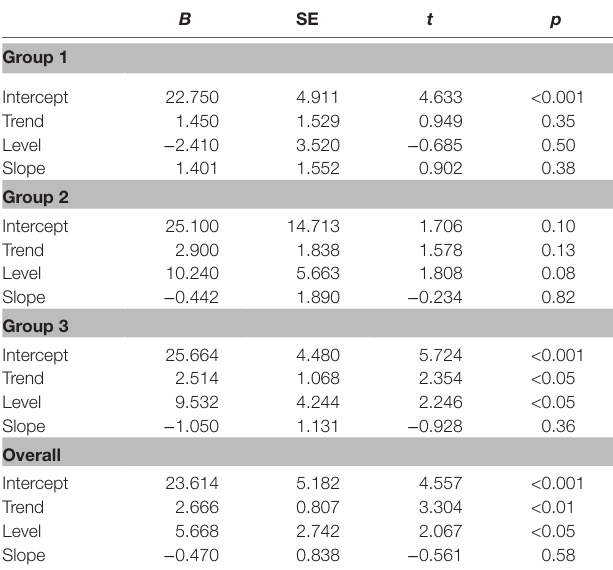
TABLE 7 | Regression model for LSF across all participants (level 2-analysis).